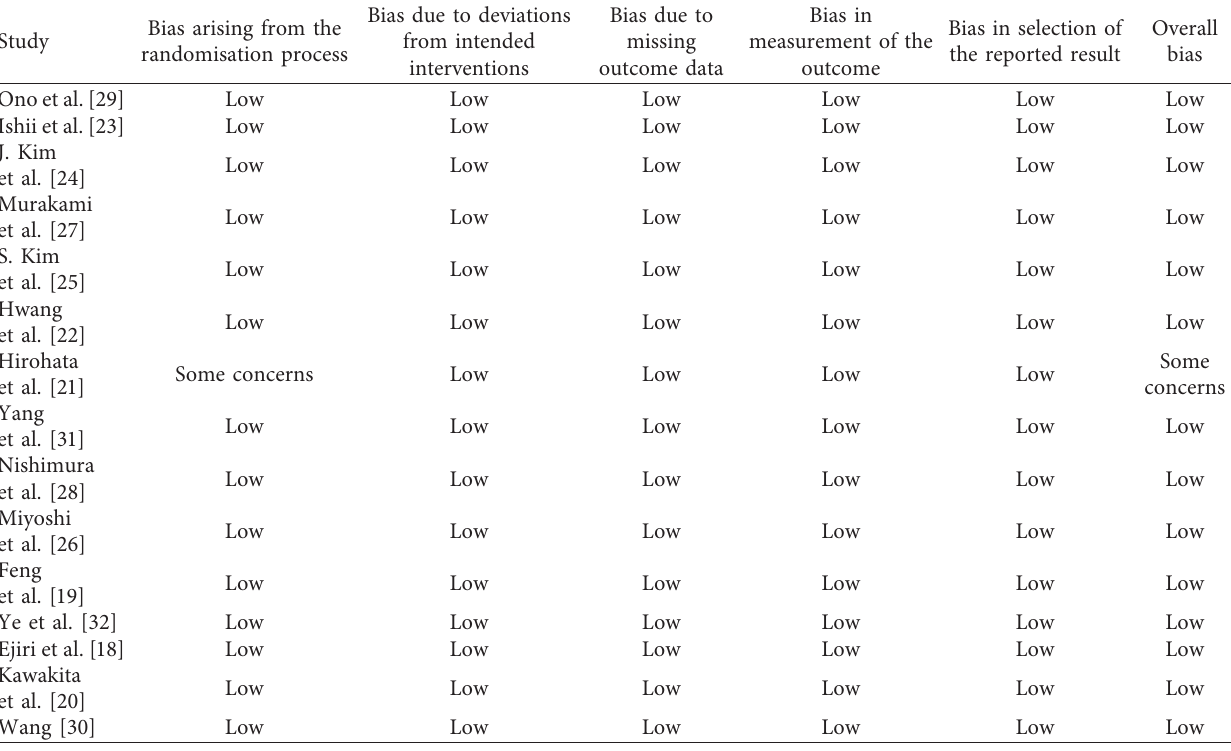
Table 2: Assessment of methodological quality of included studies.